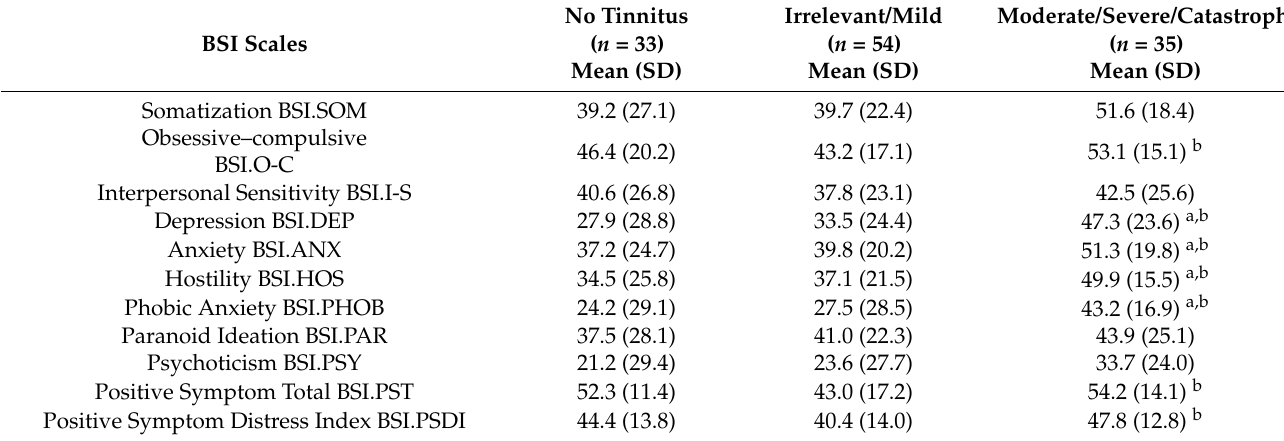
Table 9. Mean and standard deviation of BSI scores for the three groups of Tinnitus severity and results of pairwise